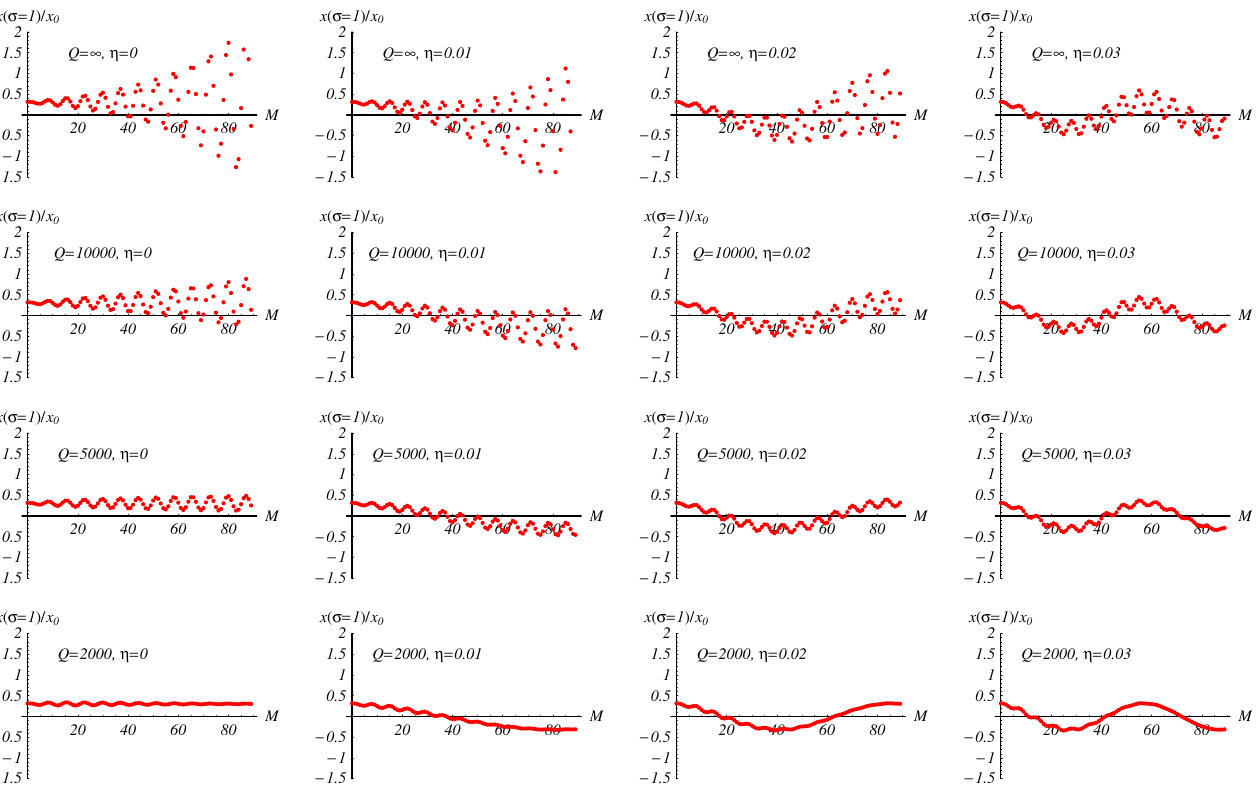
FIG. 2. (Color) Normalized lateral displacement of a finite train of pointlike bunches at the exit of a representative linear collider for different values of the Q of the deflecting mode and of the modulation of the focusing strength. See Table I for the choice of parameters.